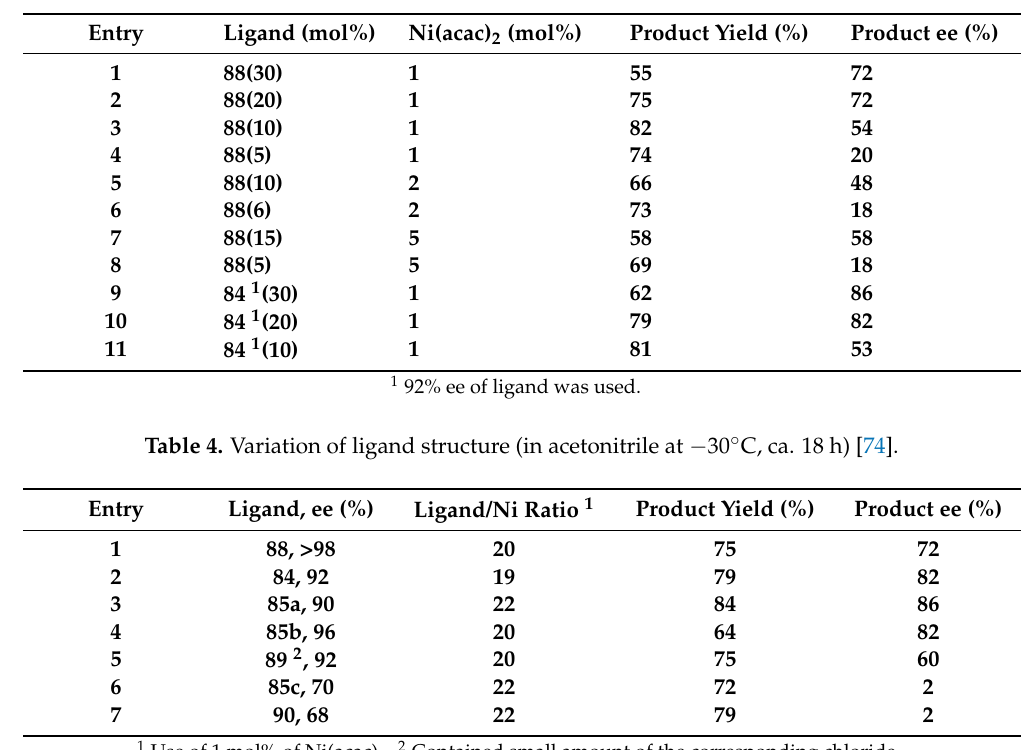
Table 3. Effect of nickel and ligand concentration (in acetone, − 30 ◦ C, 18 h) [74].